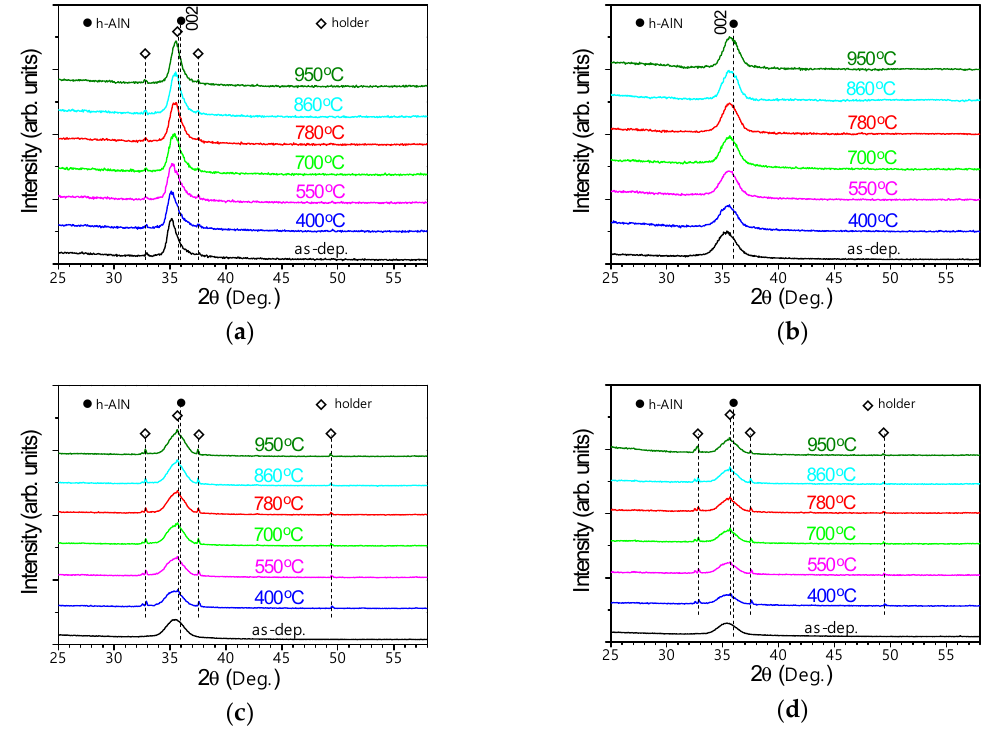
Figure 6. Evolution of XRD patterns under air annealing for AlN reference film ( a ); and AlN/SiN x multilayered films with different thickness of AlN and SiN x elementary layers: ( b ) 5 nm/2 nm; ( c ) 5 nm/5 nm; and ( d ) 5 nm/10 nm.